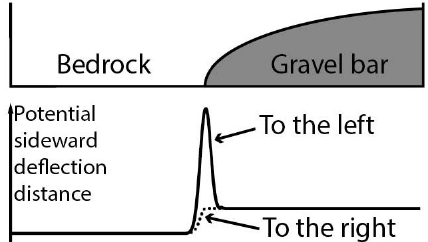
Figure 4. The potential sideward deflection distance is larger over alluvium than bedrock, since roughness elements facilitate sideward deflection of moving particles. However, the same roughness ele- ments block the path of the deflected particles, thus limiting the total distance. The largest deflection distances occur at the bound- ary between alluvium and bedrock towards the bedrock bed. Only where the particle stream intersects this point can large sideward deflection distances be